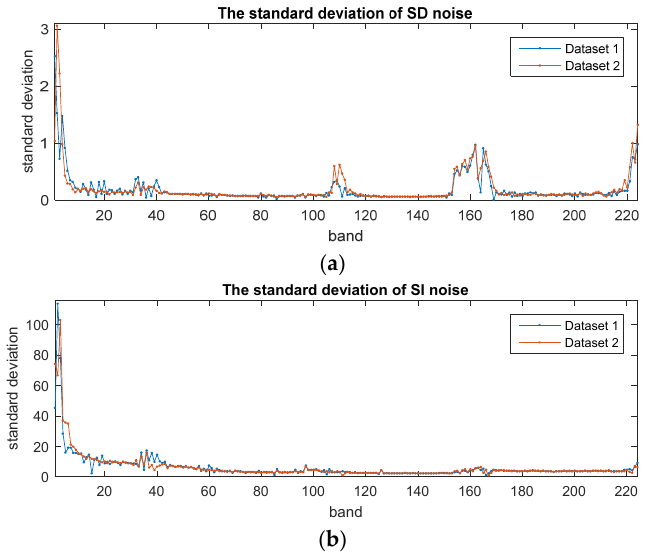
Figure 18. The standard deviations of (a) the SD noise and (b) the SI noise estimated on the two datasets covered by different ground objects from one scene.